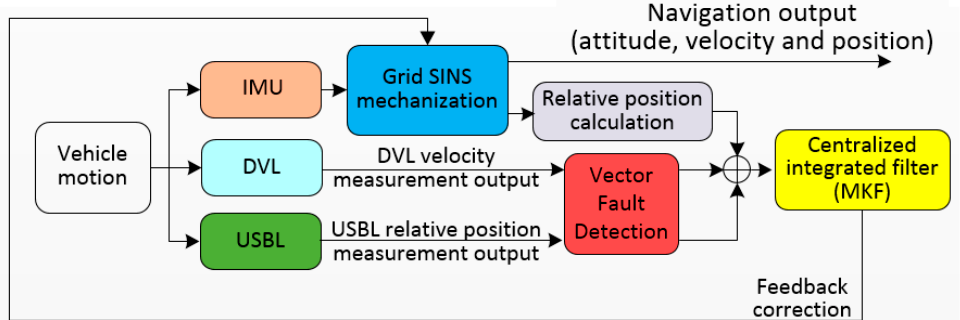
Figure 3. Diagram of the proposed grid SINS/DVL/USBL integrated navigation algorithm.